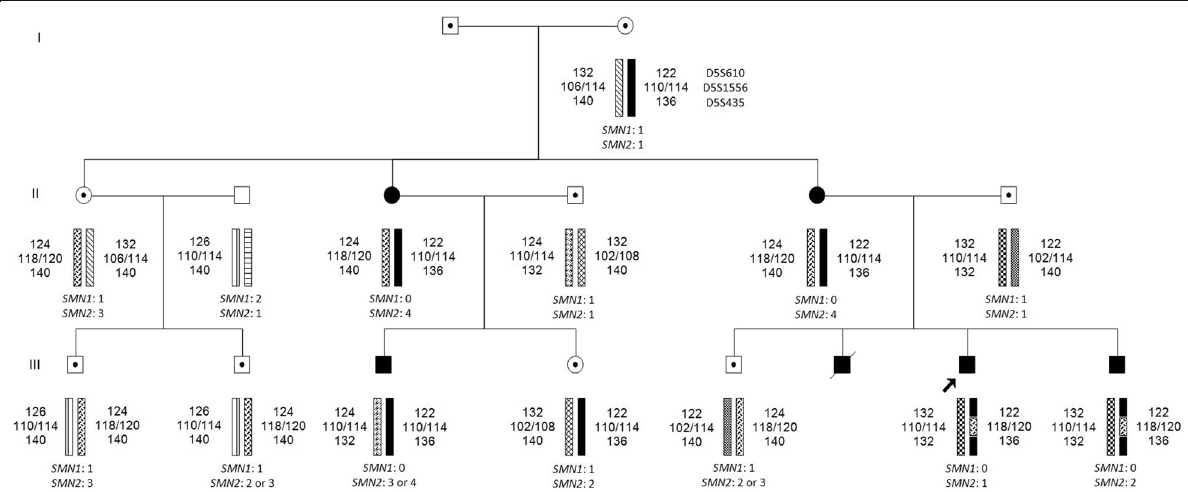
Fig. 1 Pedigree of SMA family 7, showing the copy number of the SMN genes of each studied member and the in-phase haplotype constructed with the SMA multicopies flanking markers D5S610, D5S1556, and D5S435. It is shown that the index case grandmother ’ s in-phase haplotype (122, 110/114, 140) was transmitted to the two SMA asymptomatic daughters (II-3 and II-5). In the transmission to the index case and his brother (III-7 and III-8, respectively), events of double crossing over appeared independently twice. The grandfather I-1 was not available for SMN gene testing; I-2 needed a wheelchair after her 6th decade of age due to weakness of her lower limbs. II-3 and II-5 remained asymptomatic at ages 46 and 57, respectively. Their husbands II-4 and II-6 were not biologically related, the II-6 remote ancestors came from a different geographic region than that of I-1 and I-2; the geographic origin of the ancestors of II-4 was unknown. III-6 died at 4 months of age without a molecular diagnosis of SMA. III-3, III-7, and III-8 were still alive at ages 18, 30, and 34, respectively, when the study was